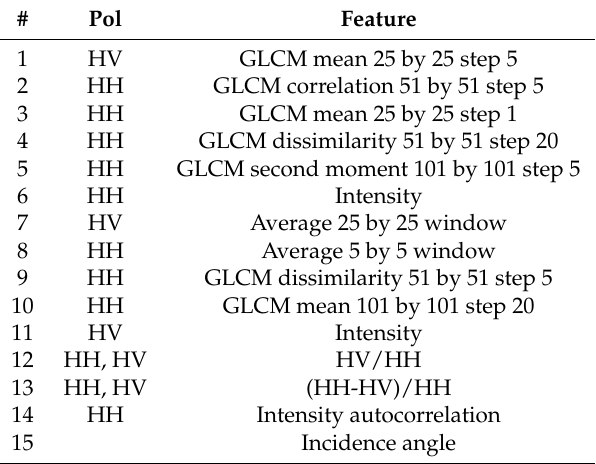
Table 3. Image features used for method